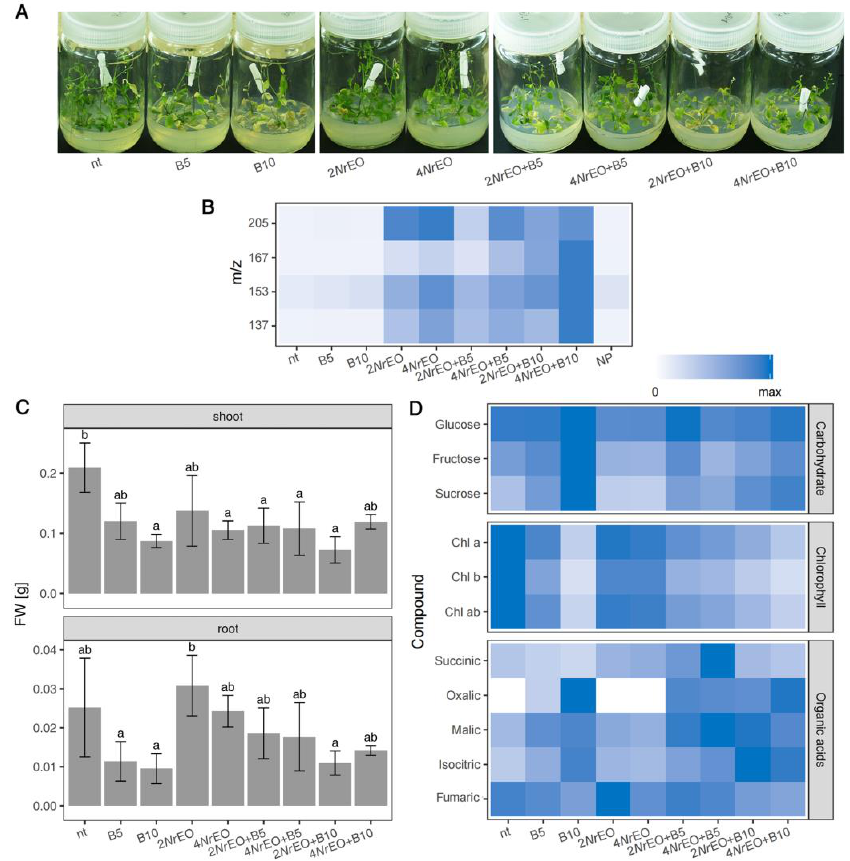
Figure 1. The effects of herbicide BASTA (B5 and B10, with 5 and 10 mg l −1 glufosinate ammonium, respectively), and N. rtanjensis essential oil volatiles (2 Nr EO and 4 Nr EO with 2% and 4% Nr EO, respectively) and their combined application on Arabidopsis plants. ( A ) in vitro grown Arabidopsis exposed to different combinations of BASTA and/or Nr EO, as well as non-treated (nt) plants. BASTA was supplied through culture medium, while Nr EO volatiles were present in the atmosphere of the glass jars. ( B ) Values of the relative abundances (ppbV, parts-per-billion-volume) of organic volatiles present in the atmosphere of the glass vessels after 10 days of the treatment, revealed by the PTR-MS measurements, are presented relatively as a heat-map: [H+1] − at m / z 167— cis , trans -nepetalactone + trans , cis -nepetalactone; [M+1] − at m / z 137 and m / z 153—total monoterpenoids ( m / z 137— α - and β -pinene, m / z 153— α -campholenal, neral and geranial); [H+1] − at m / z 205—total sesquiterpenoids ( γ - and δ - cadinene, cis - and trans -caryophyllene, and α -humulene). ( C ) Arabidopsis shoot fresh weight (FW) and root FW. Values are presented as means ± SD. Significant differences according to Tukey’s HSD post-hoc test at p < 0.05 are indicated with a compact letter display. ( D ) Content of chlorophylls (Chl a, Chl b, Chl a+b), organic acids (succinic, oxalic, malic, isocitric and fumaric acid) and soluble sugars (glucose, fructose and sucrose) in shoots. Maximal values on the colour scales represent maximal values recorded for each parameter. Abbreviations: nt- non treated plants; NP- culture vessels containing no plants; B- BASTA; Nr EO- Nepeta rtanjensis essential